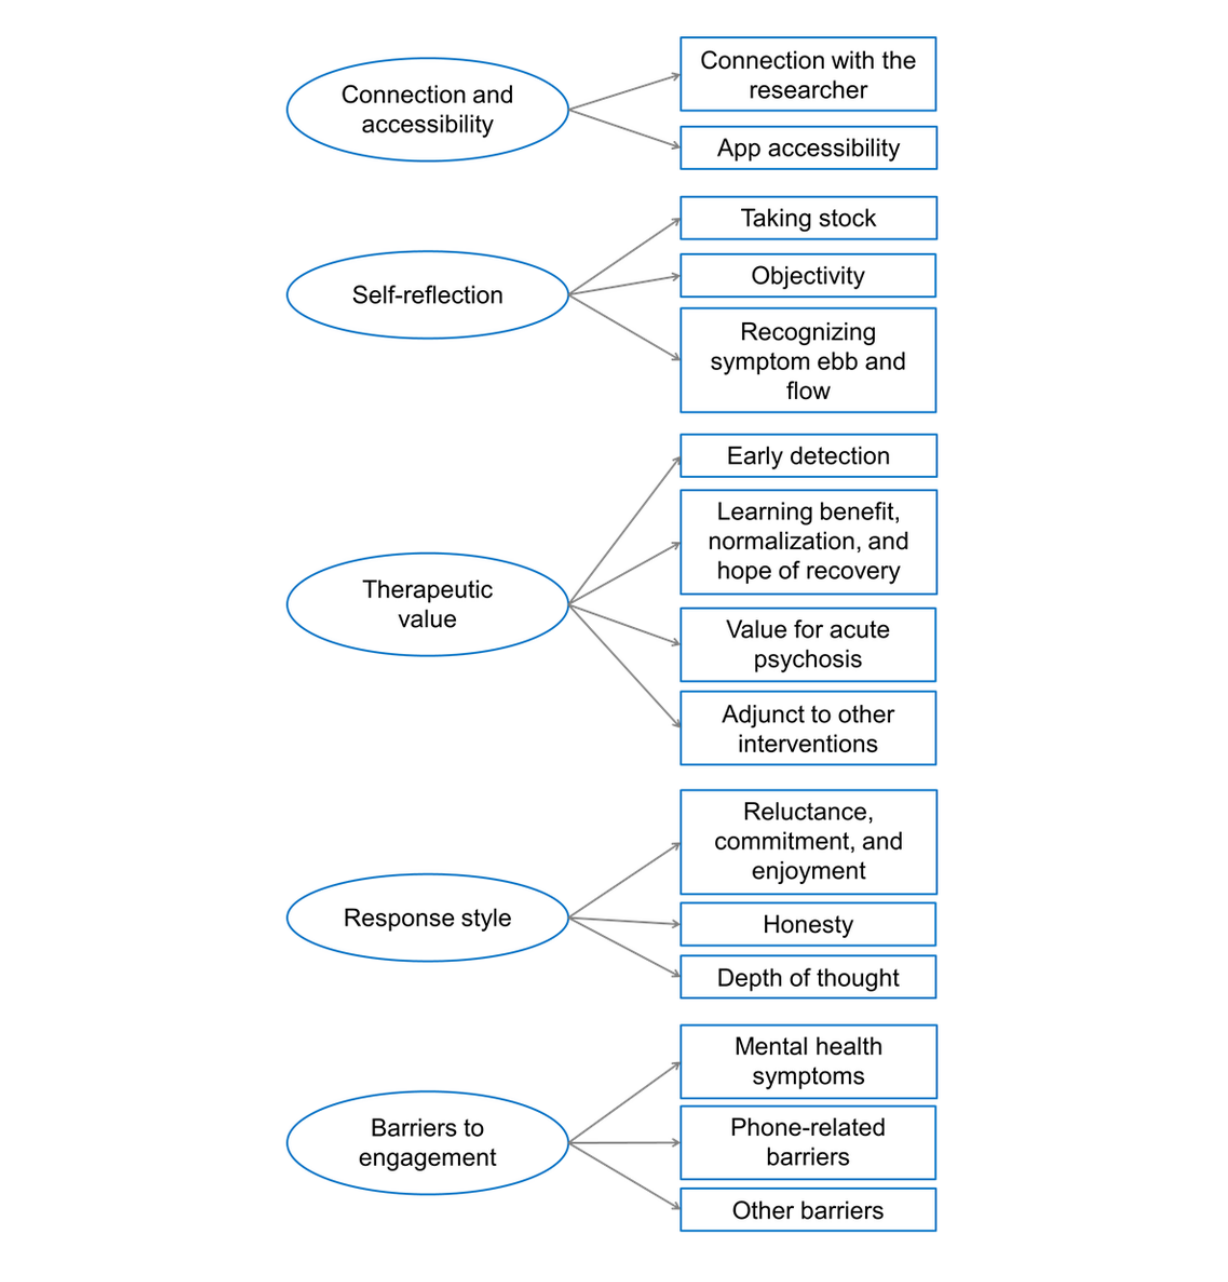
Figure 3. Summary of a posteriori themes and